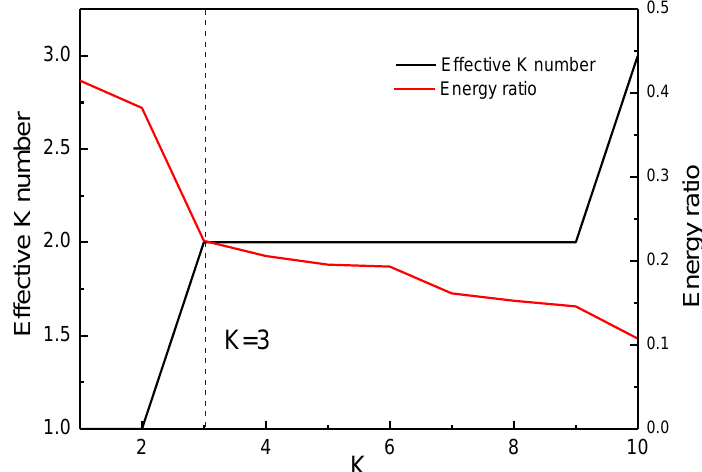
Figure 9. Curves of two main parameters of valve clearance reduction (0.25, 0.45).